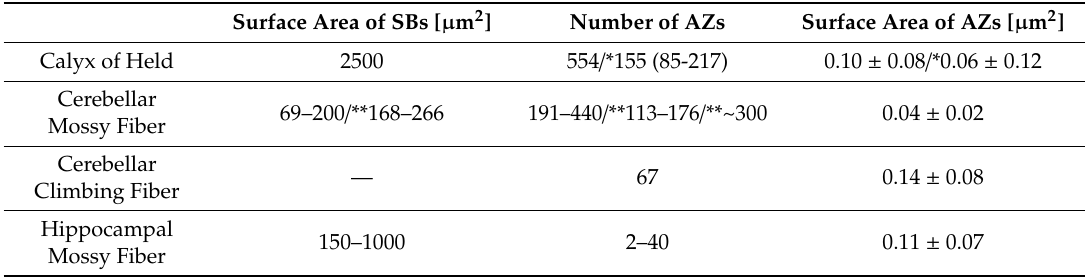
Table 2. Comparison of structural features of central